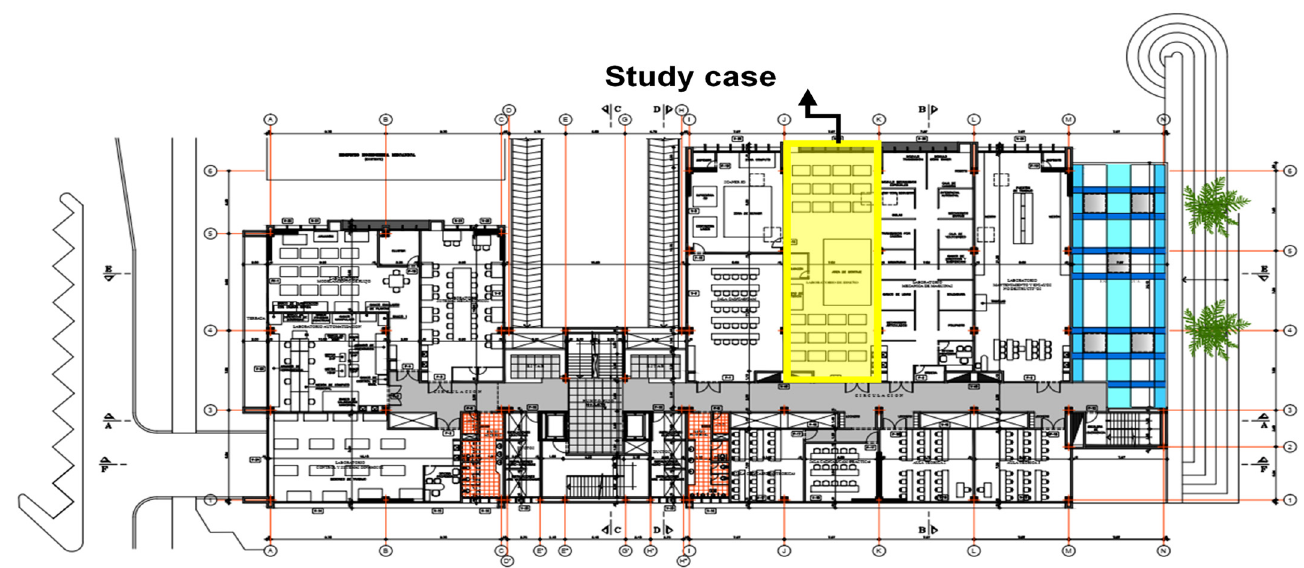
Figure 5. Building top view, Design Laboratory highlighted.